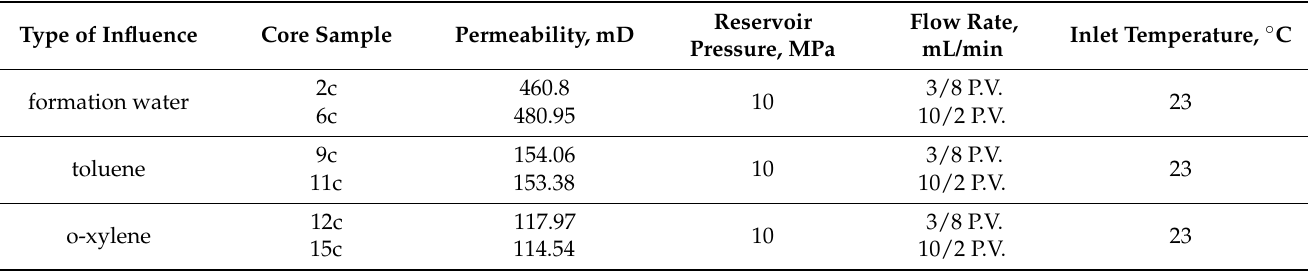
Table 9. Conditions for conducting the